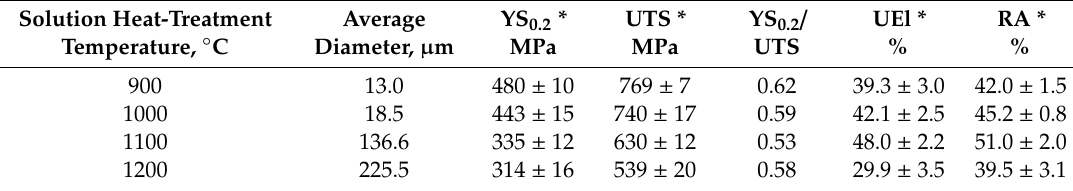
Table 3. Effect of grain size on mechanical properties. Table 3. E ff ect of grain size on mechanical properties.